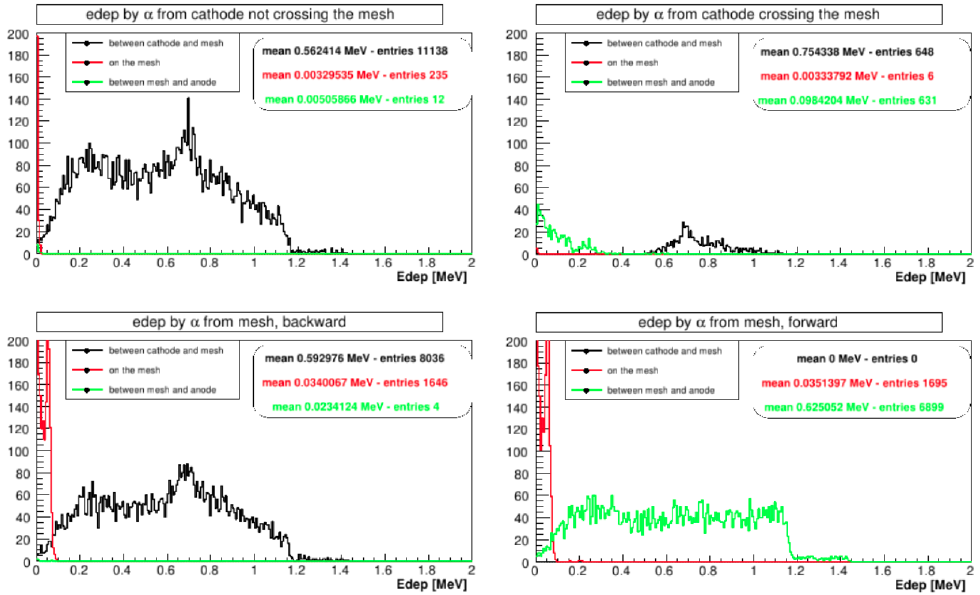
Fig. 4. Deposited energy distributions for α particles produced on a µRWELL having a boron-coated cathode and a boron-coated mesh. The distributions are separated in regions to define the amount of expected primary electrons as a function of the ionization regions. Four different conditions were simulated: α particles from the cathode not crossing the mesh, α particles from the cathode crossing the mesh, α from the mesh to the cathode and α from the mesh to the